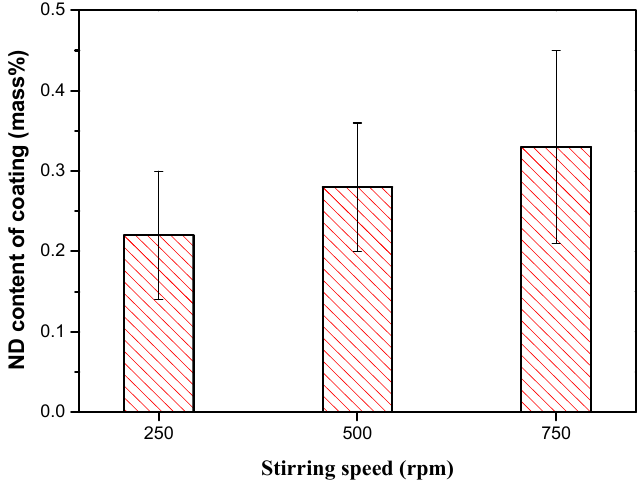
Figure 5. Relation between stirring speed and nano diamond (ND) content of the coatings [55].